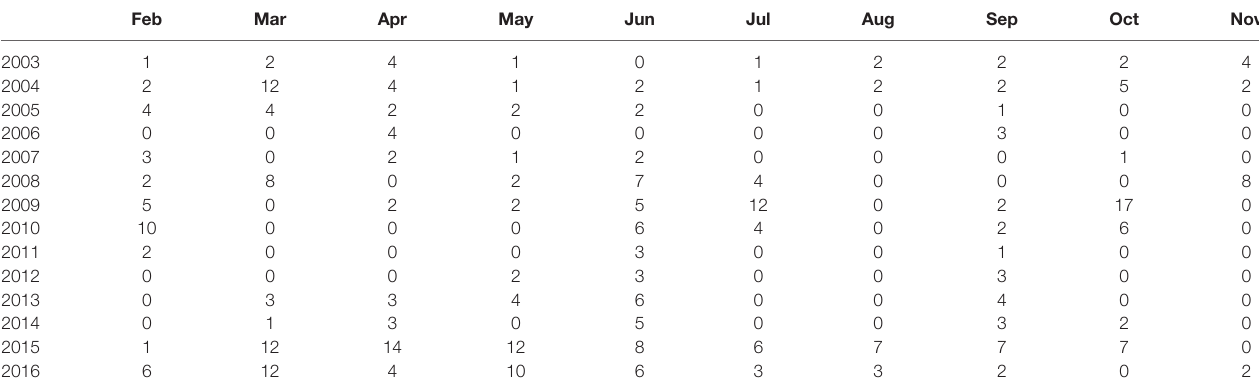
TABLE 1 | Number of zooplankton samples collected in the Central Strait of Georgia, BC, by month from 2003-2016.